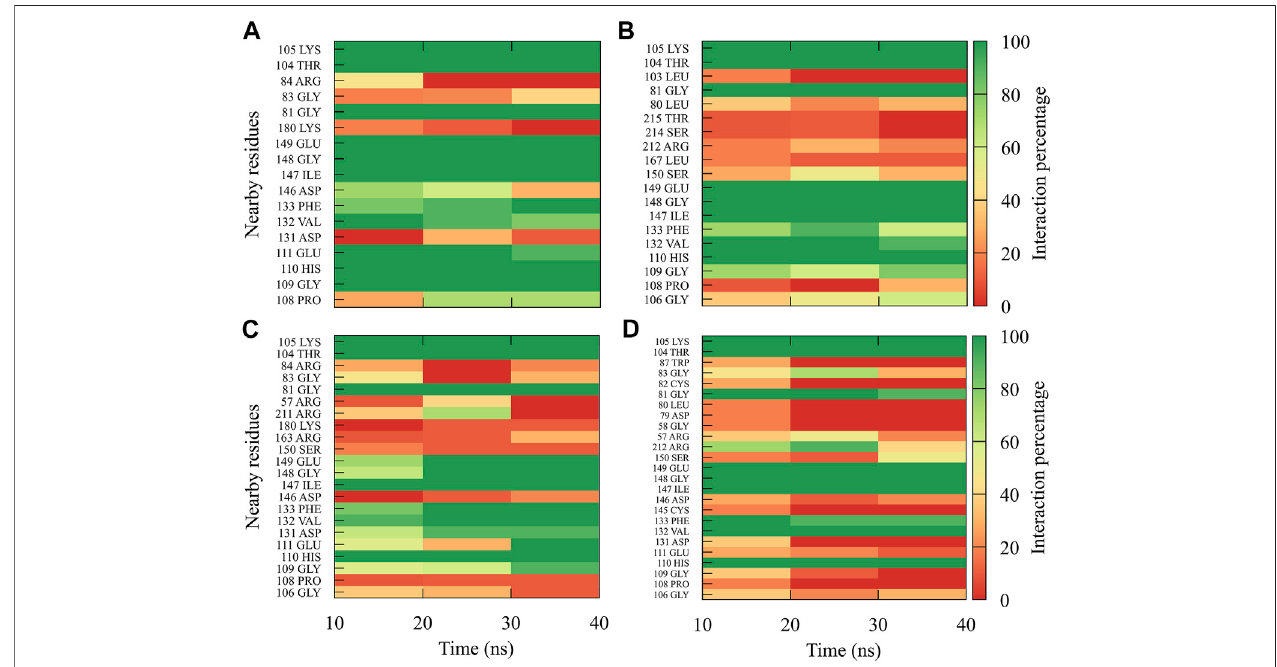
FIGURE 7 | Contact frequency maps for the compound 9sd , bound to the SAM binding-site of the (A) DENV1, (B) DENV2, (C) DENV3, and (D) DENV4. Red represents that the contact frequency was 0%, while green represents that the contact frequency was 100%.